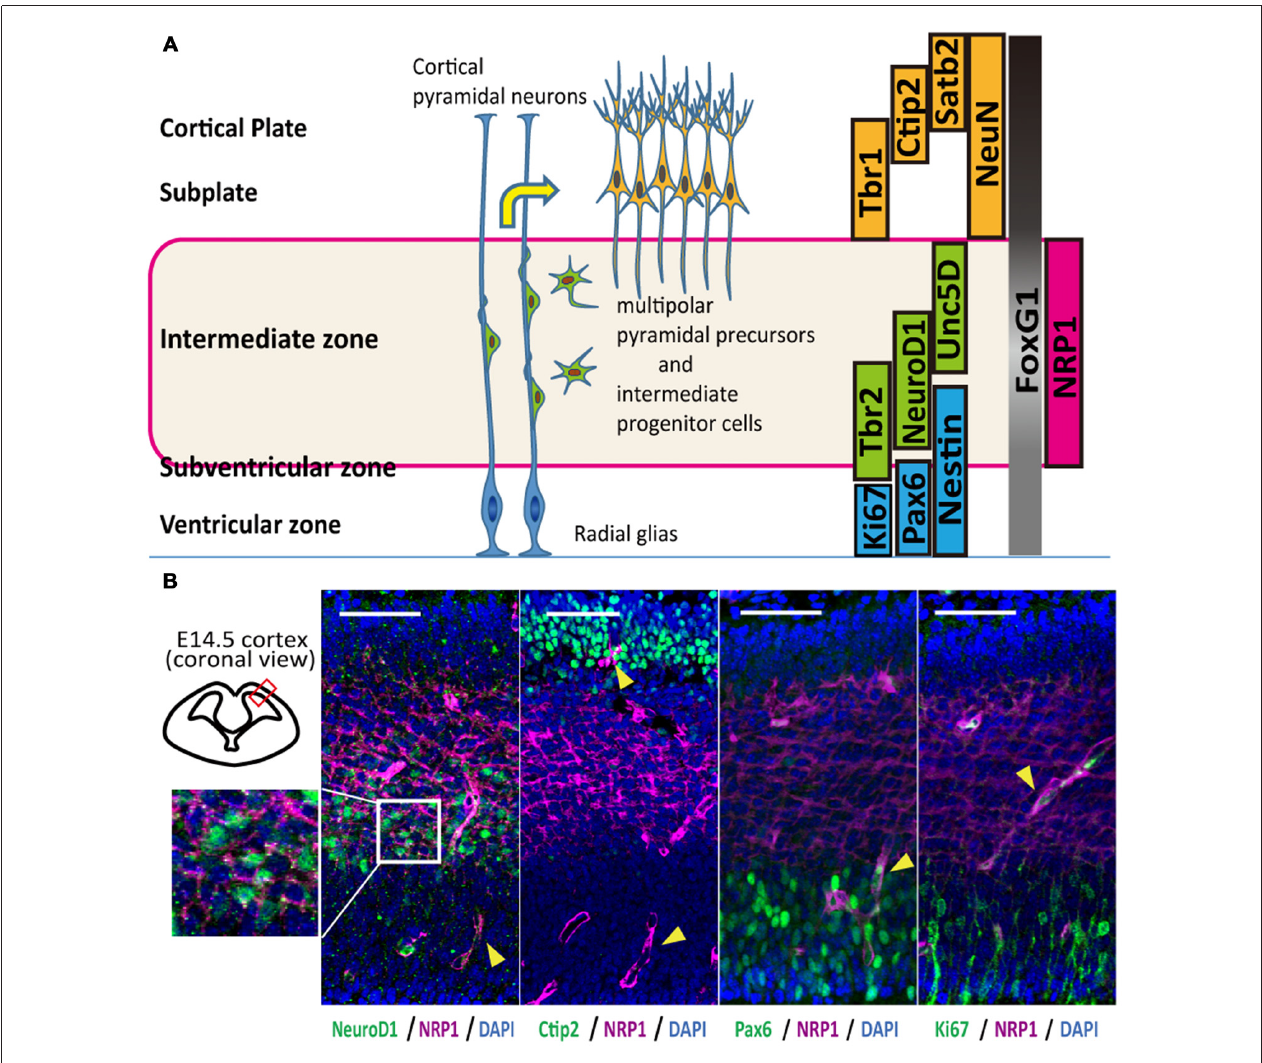
FIGURE 1 | Anatomical distribution and function of Neuropilin-1 (NRP1) as an axonal guidance molecule in different developmental stages. (A) Schematic diagram of the maturation of cortical pyramidal neurons and markers related to the cortical layers. (B) Immunohistological analysis of the anatomical NRP1 (magenta) distribution in E14.5 mouse cortex. Arrowheads indicate blood vessels. Scale bars, 50 µ